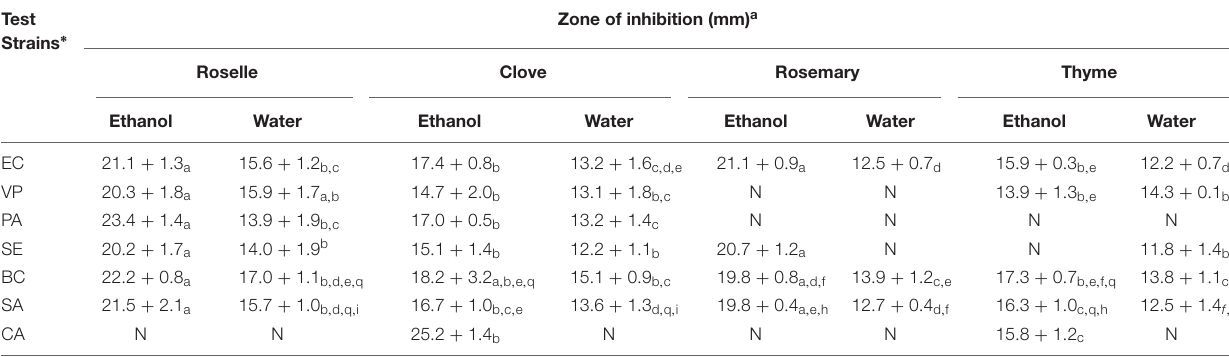
Zone of inhibition (mm) a